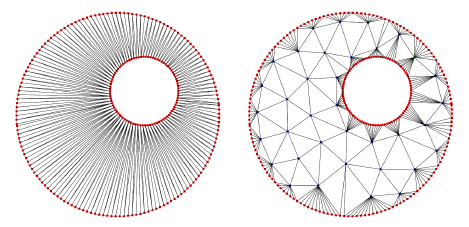
Figure 10. Left: Meshing based on planting distance. Right: Meshing based on model size and planting